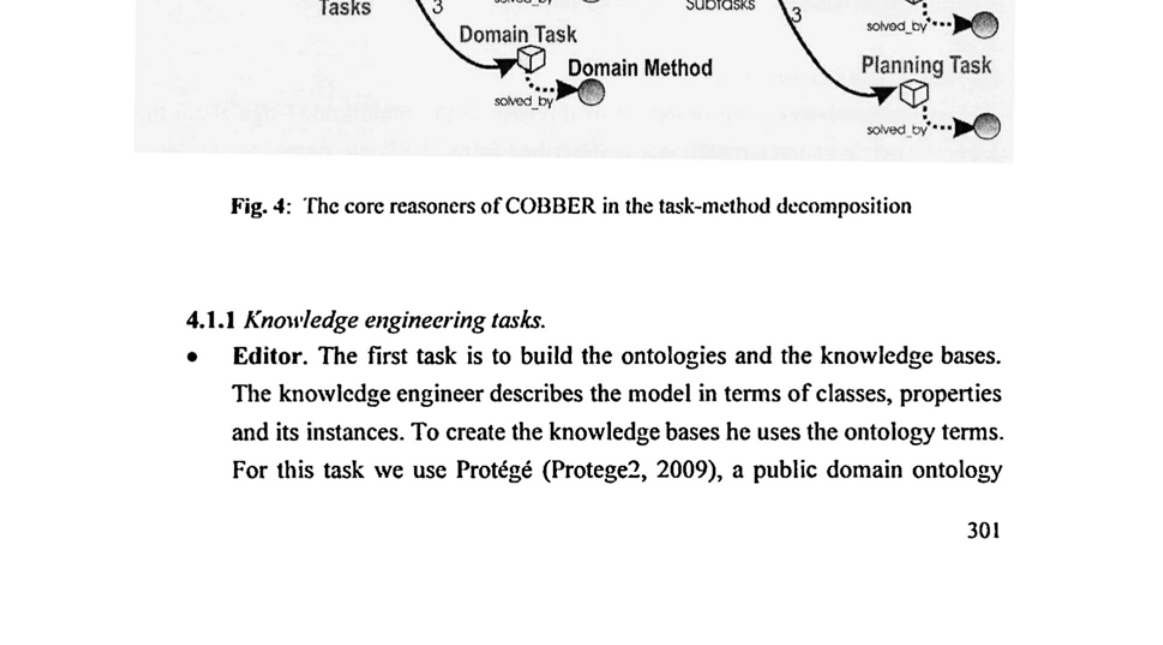
Fig. 4: The core reasoners of COBBER in the task-method decomposition